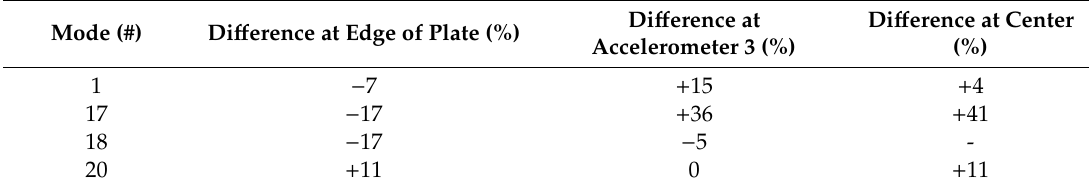
Table 10. Di ff erence of the numerical model prediction with experimental results for modes with delamination of the